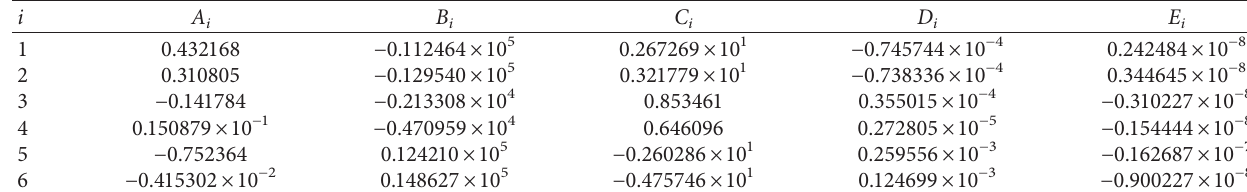
Table 1: Olikara and Borman equilibrium constant curve-fit coefficients.